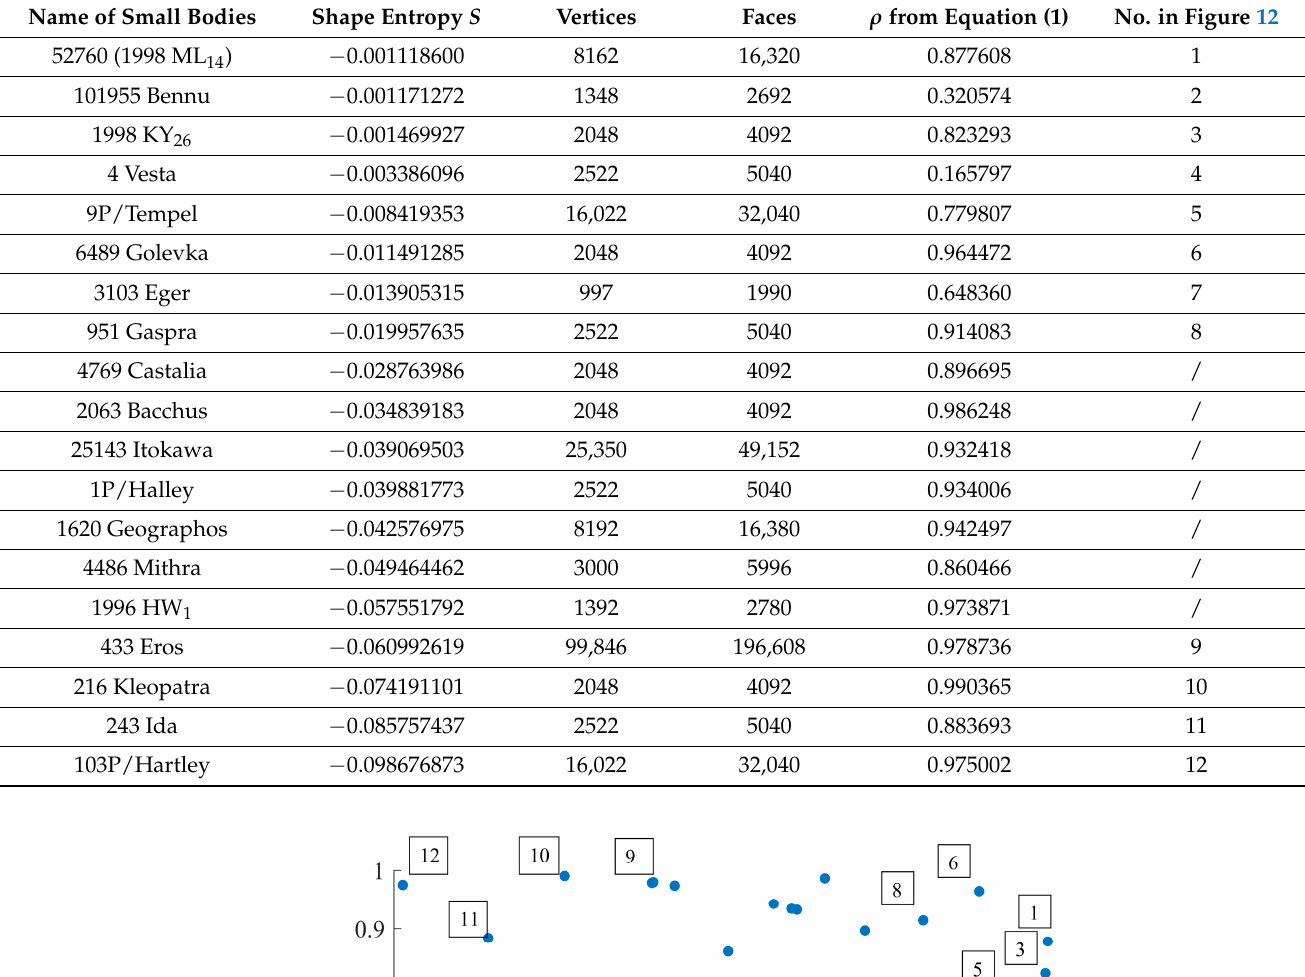
Table 5. The shape entropies of polyhedral models of small bodies.